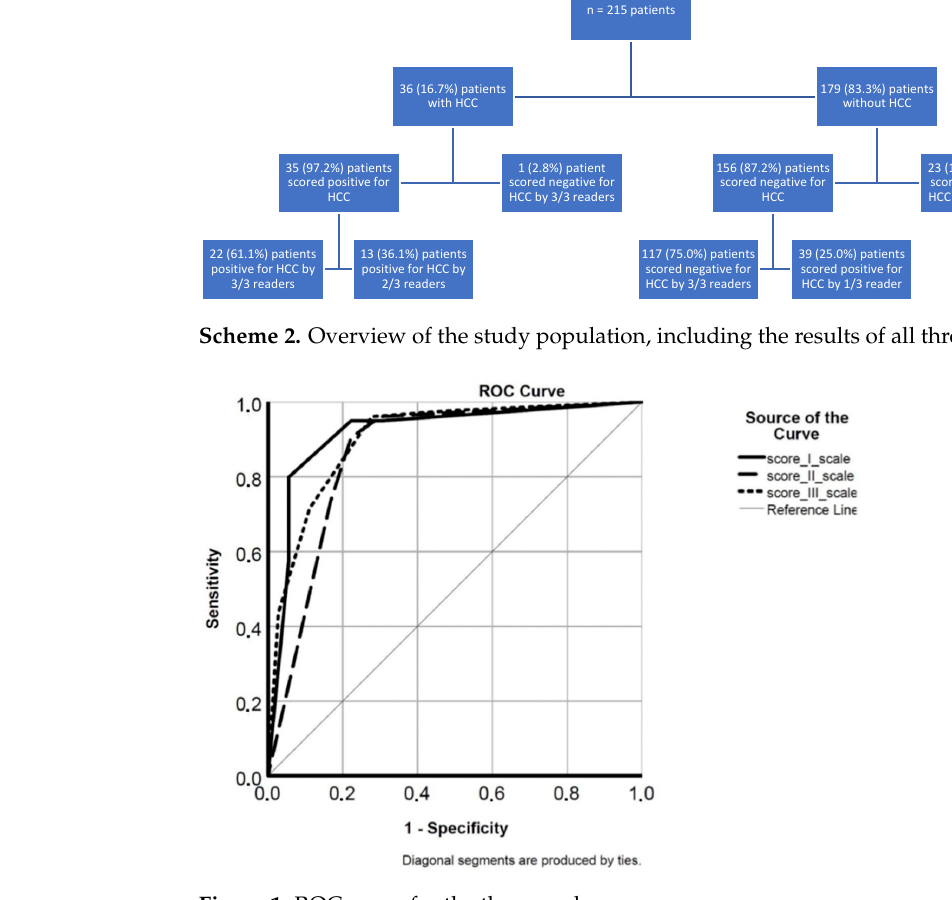
Figure 1. ROC curve for the three readers. Area under the curve (AUC): reader I 0.94 (95% CI 0.90–0.99), reader II 0.88 (95% CI 0.81–0.96), and reader III 0.93 (95% CI 0.89–0.97). AUC of 1.0 indicated a perfect model, whereas 0.5 indicated a very poor model. Generally, AUC > 0.7 indicates a good model. Figure 2. Fifty-two-year-old male patient with liver cirrhosis owing to chronic hepatitis C infection. NC-AMRI ( a – d ) demonstrates a small lesion (arrow ( a – f )) in segment 4 that is hyperintense on axial T2W FS ( a ) and DWI ( b ), and hypointense on T1W in-phase ( c ) and opposed-phase ( d ) imaging,